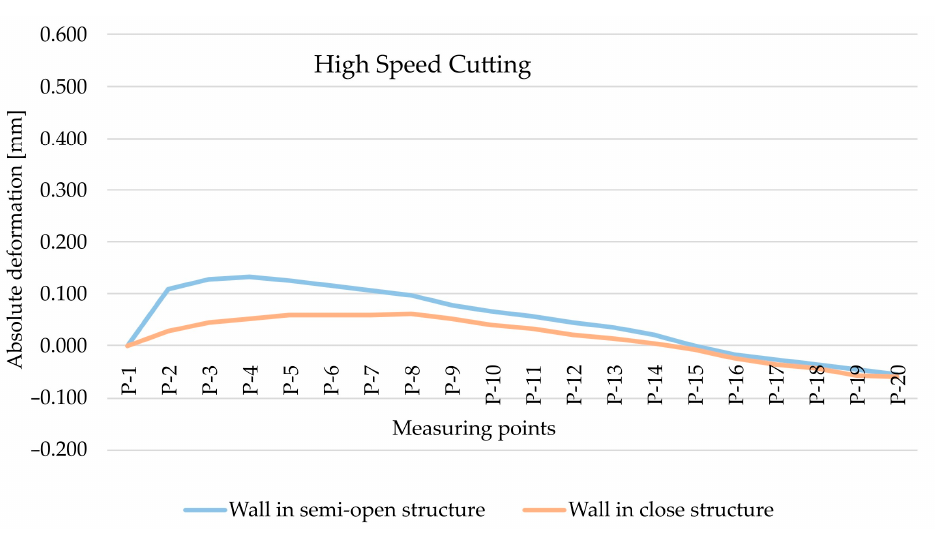
Figure 8. The comparison of absolute deformation for individual measurement points depending on the geometry of the thin-walled sample for HSC and for the EN AW-7075 T651 aluminium alloy.